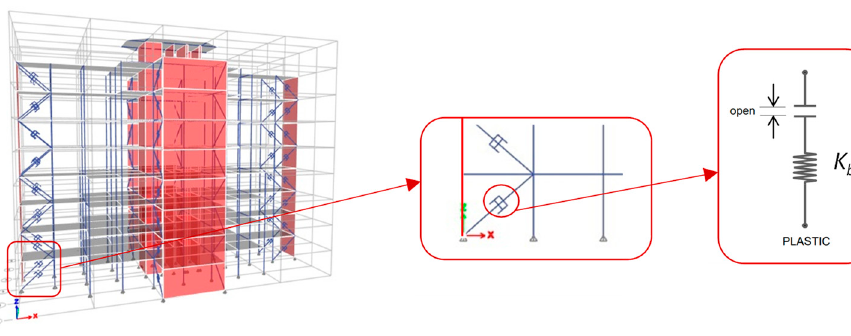
Figure 11. Modeling configuration of FDs.